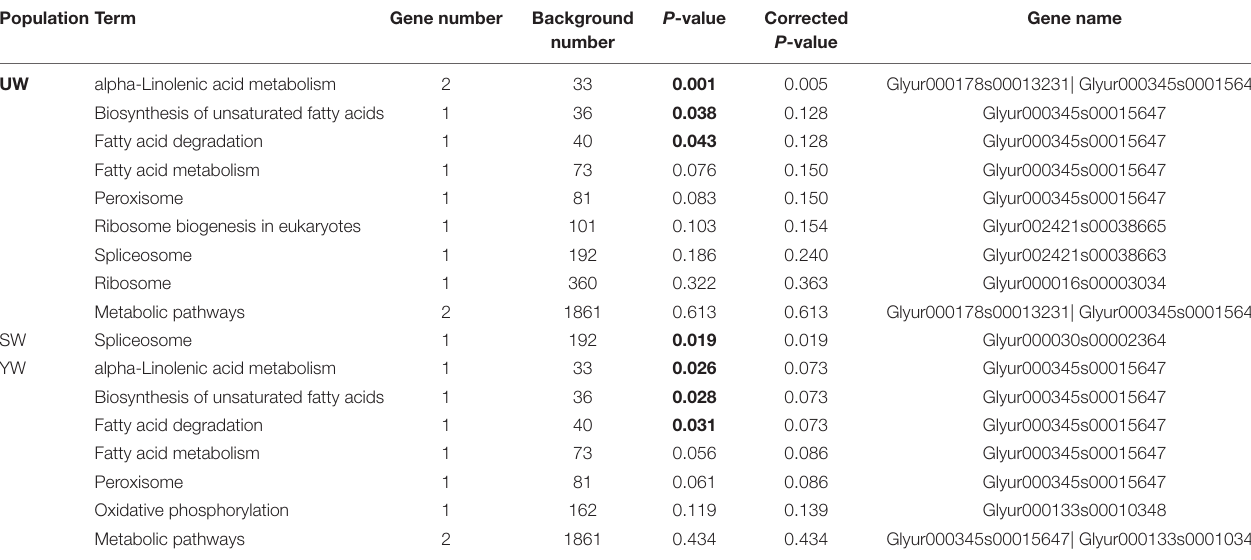
TABLE 4 | G. uralensis population pathway analysis of Kyoto Encyclopedia of Genes and Genomes (KEGG) based on candidate gene. Population